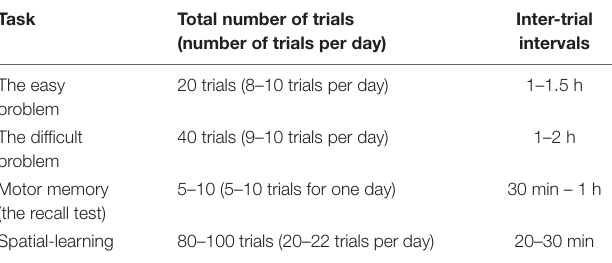
TABLE 1 | Experimental protocol of the four